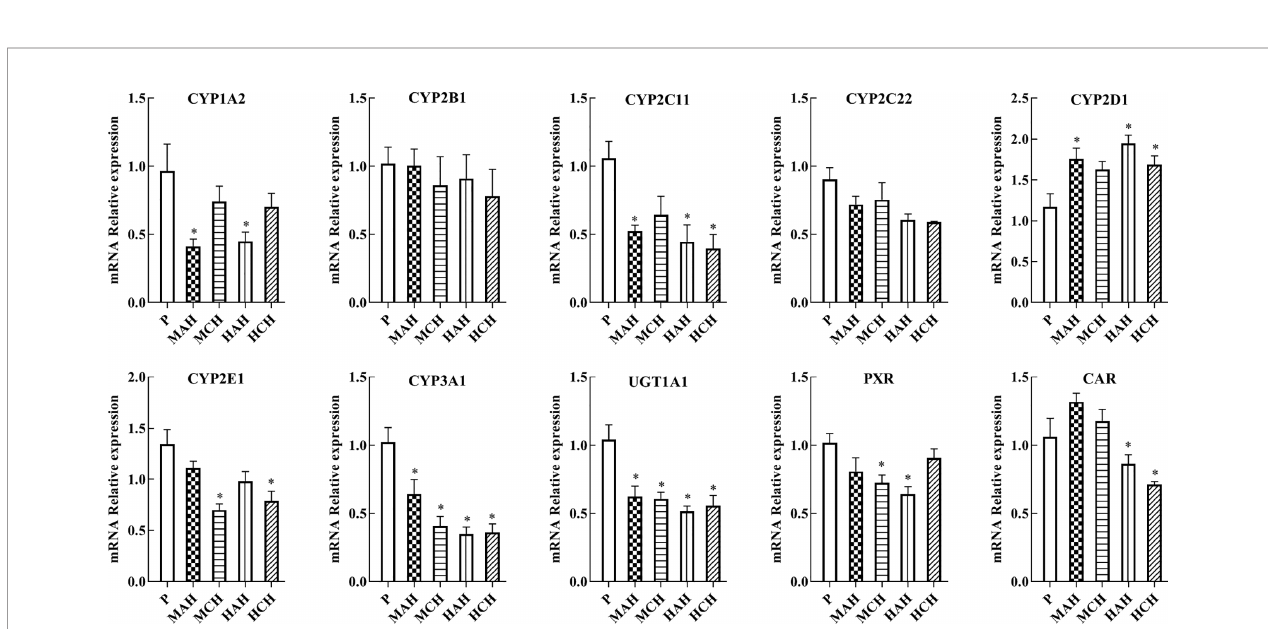
FIGURE 3 | mRNA expression of CYP1A2, CYP2B1, CYP2C11, CYP2C22, CYP2D1, CYP2E1, CYP3A1, UGT1A1, PXR, and CAR in rats. P: plain group (altitude: 390 m, PaO 2 : 20 kPa), MAH: acute moderate-altitude hypoxia group (altitude: 2,800 m, PaO 2 : 15.1 kPa; Rats were exposed to moderate altitude for 24 h), MCH: chronic moderate-altitude hypoxia group (altitude: 2,800 m, PaO 2 : 15.1 kPa; Rats were exposed to moderate altitude for 30 days), HAH: acute high-altitude hypoxia group (altitude: 4,300 m, PaO 2 : 12.4 kPa; Rats were exposed to high altitude for 24 h), HCH: chronic high-altitude hypoxia group (altitude: 4300 m, PaO 2 : 12.4 kPa; Rats were exposed to high altitude for 30 days). The data were analyzed using a one-way analysis of variance (ANOVA), and the differences between the means of two groups were compared using LSD tests. * indicates the signi fi cance of experimental groups, compared with that of the control. Values are expressed as Mean ± SEM (n = 10). Levels are considered signi fi cant at * p <